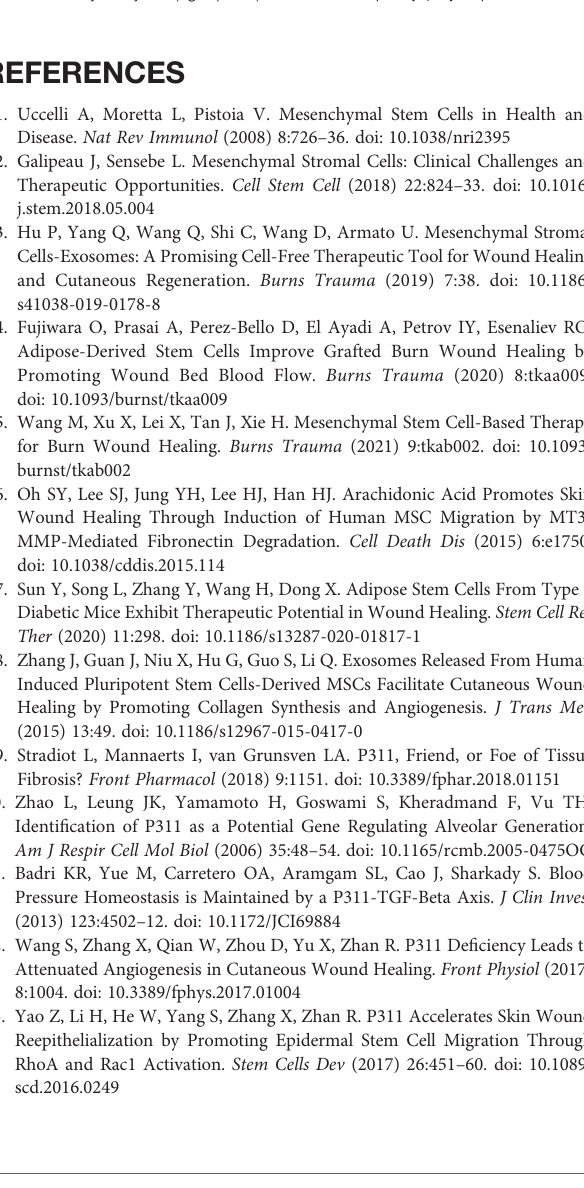
Masson staining images in granulation tissues were shown (left panel), and the contents of total collagen were statistically analysed (right panel). Scale bar: 50 µm. Data are representative of at least three independent experiments and represent mean±SDofindicated numberofmiceper group.(ns,nostatistical signi fi cance;*P < 0.5; **p < 0.01; ***p < 0.001). Supplementary Figure 6 | PI3K-AKT-mTOR signalling pathway is activated in wound tissues for mice with MSCs P311 treatment. The activation of PI3K-AKT- mTOR signalling pathway in wound tissues for mice with MSCs, MSCs Ctrl and MSCs P311 administration was examined by immunoblot. (A – D) Representative western blot images were shown, and the ratio of phosphorylated to total proteins were statistically analysed. Data are representative of at least three independent experiments and represent mean ± SD of indicated number of mice per group. (**p < 0.01; ***p < 0.001). Supplementary Figure 7 | The security assessment of mice with MSCs, MSCs Ctrl and MSCs P311 treatment. These organs (heart, liver, spleen, lung and kindey) were harvested from normal mice and mice with MSCs, MSCs Ctrl and MSCs P311 administration. The tissue structure of organs were observed by H&E staining. (A) Representative H&E staining images for heart, liver, spleen, lung and kindey. Scale bar: 200 µm. Data are representative of at least three independent